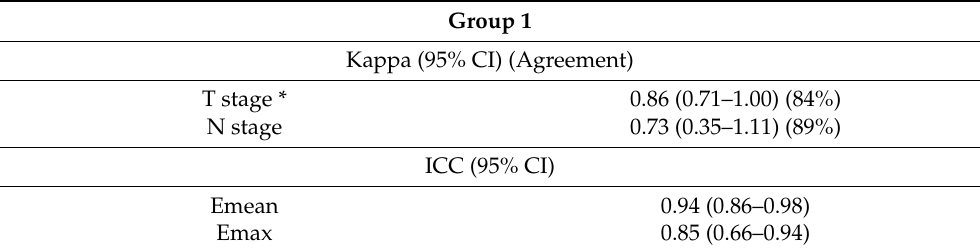
Table 1. Interobserver agreement on tumor T and N stage and shear wave elastography value in Group